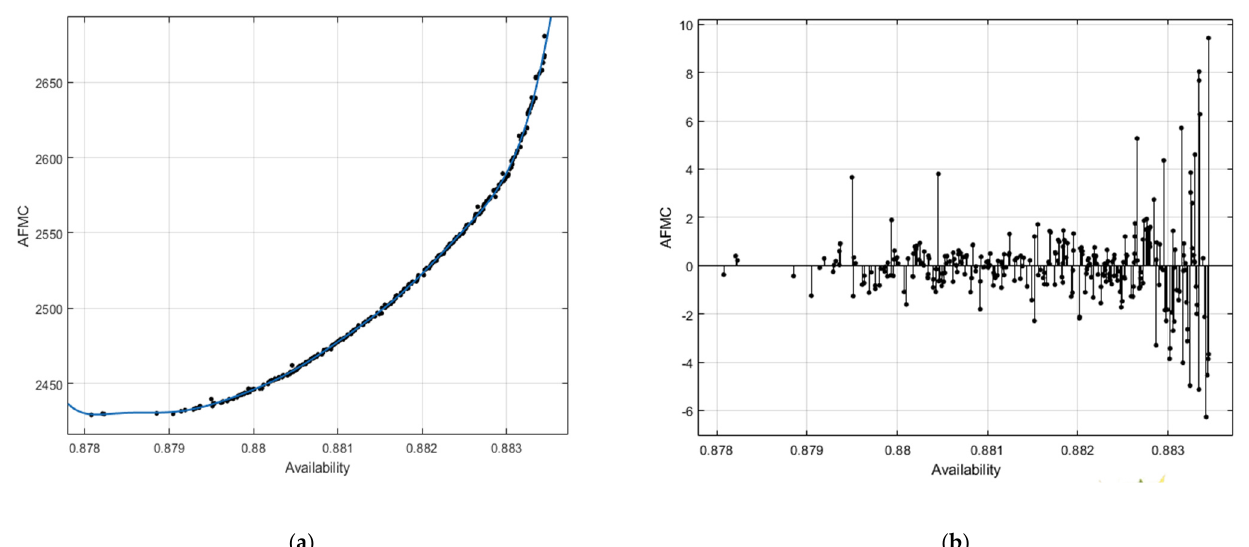
11 of 14 Figure 6. Convergence of objective function. ( a ) Dual-objective model iteration results; ( b ) Three- objective model iteration results. The brake assembly is already a product with frequent planned maintenance tasks in the system; the change of availability is still not obvious under the option selection decision. The target results of the final scheme have few differences between the two models. The model considering the dual-objective model locates the optimal solution area faster and searches for more elite individuals of the neighborhood in the subsequent iteration process, all of which is to increase efficiency and global search ability. For the case itself, the cost optimization needs not require too high of an accuracy, but this is the inherent merit of the model itself, and it can also reduce the number of iterations through this feature, thus resulting in less time to solve the model. This analysis provides a model comparison for the subsequent option selection of the whole system, so the dual-objective mathematical optimization model is used to solve the problem later. 4. Validation and Verification Process 4.1. Product Option Selection Decision Based on the Mathematical Optimization Model Taking all 61 products of the landing gear system as optimization objects, a mathematical optimization model for product selection was constructed. The distribution relationship and convergence accuracy between availability and the AFMC is shown in Figure 7. For 61 categories of individuals in the decision space optimization, when the number of iterations was 100, the decision space tended to converge and stabilized after the 200th generation. When the number of iterations was 300, the population is the result, and the two objective functions have a certain convergence in the decision space, which is consistent with the condition of the end of iteration. This indicates that there is a certain functional relationship between the maintenance cost and availability of an aircraft fleet. The convergence relationship between the two indicates that the optimal solution found